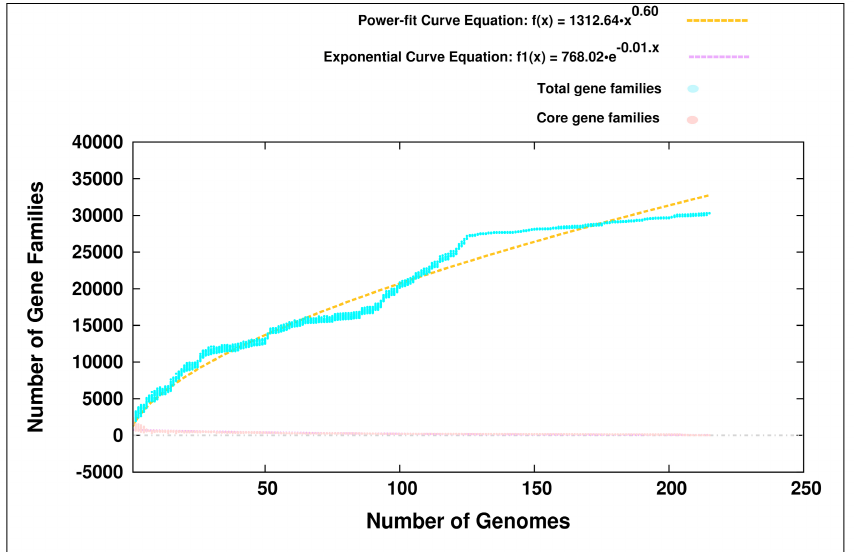
Figure 1. Plot of pan- and core-genomes of the genus Bifidobacterium ( n = 215 members). Pan-genome estimate is shown after using 30 random samples of the 215 genomes. The plot represents a stabilized core structure but an open